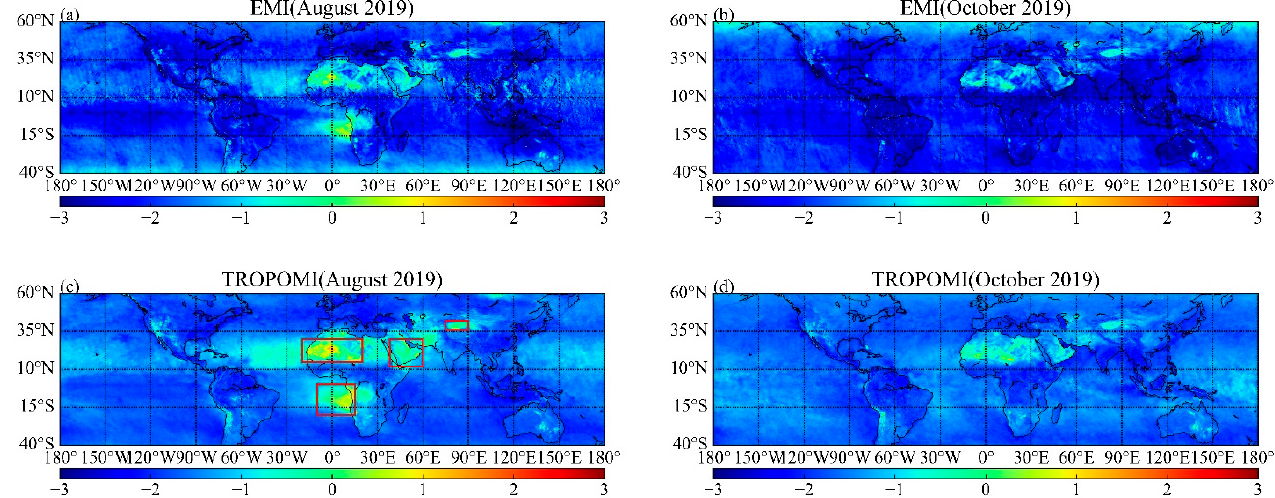
Figure 4. Global distribution of the monthly averaged AAI from EMI ( top ) and TROPOMI ( bottom ) in August ( a , c ) and October ( b , d ) 2019. Red boxes delimit the African dust region (20W–20E, 15N–30N), Taklimakan (75E–90E, 36N–42N), Southern Africa (10W–15E, 20S–0), and Middle East (38E–60E, 12N–30N) biomass burning